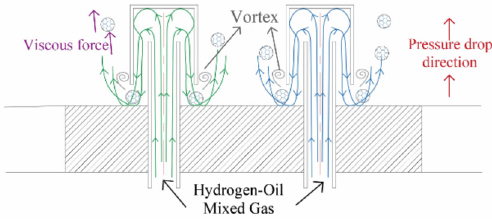
Fig. 5. Flow fi eld diagram of reactor.